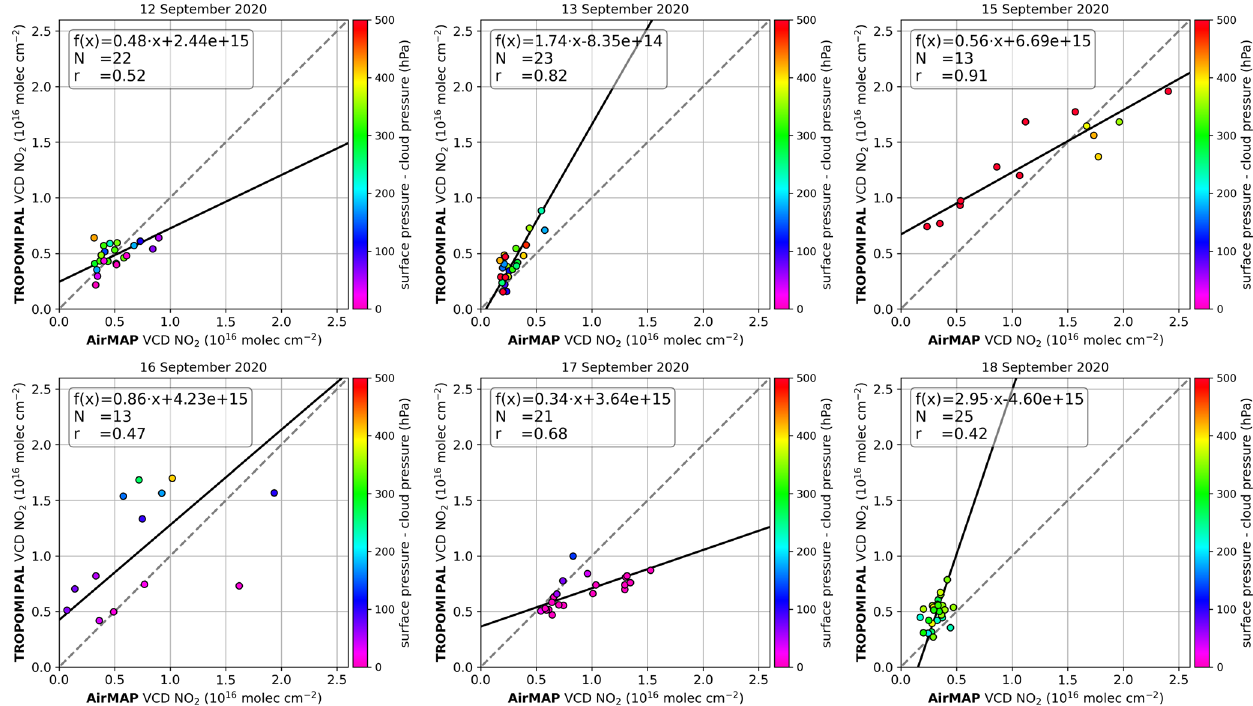
Figure A9. The same as Fig. A8 but for TROPOMI PAL V02.03.01 tropospheric NO 2 VCDs vs. co-located AirMAP tropospheric NO 2 VCDs for the 6 measurement days.